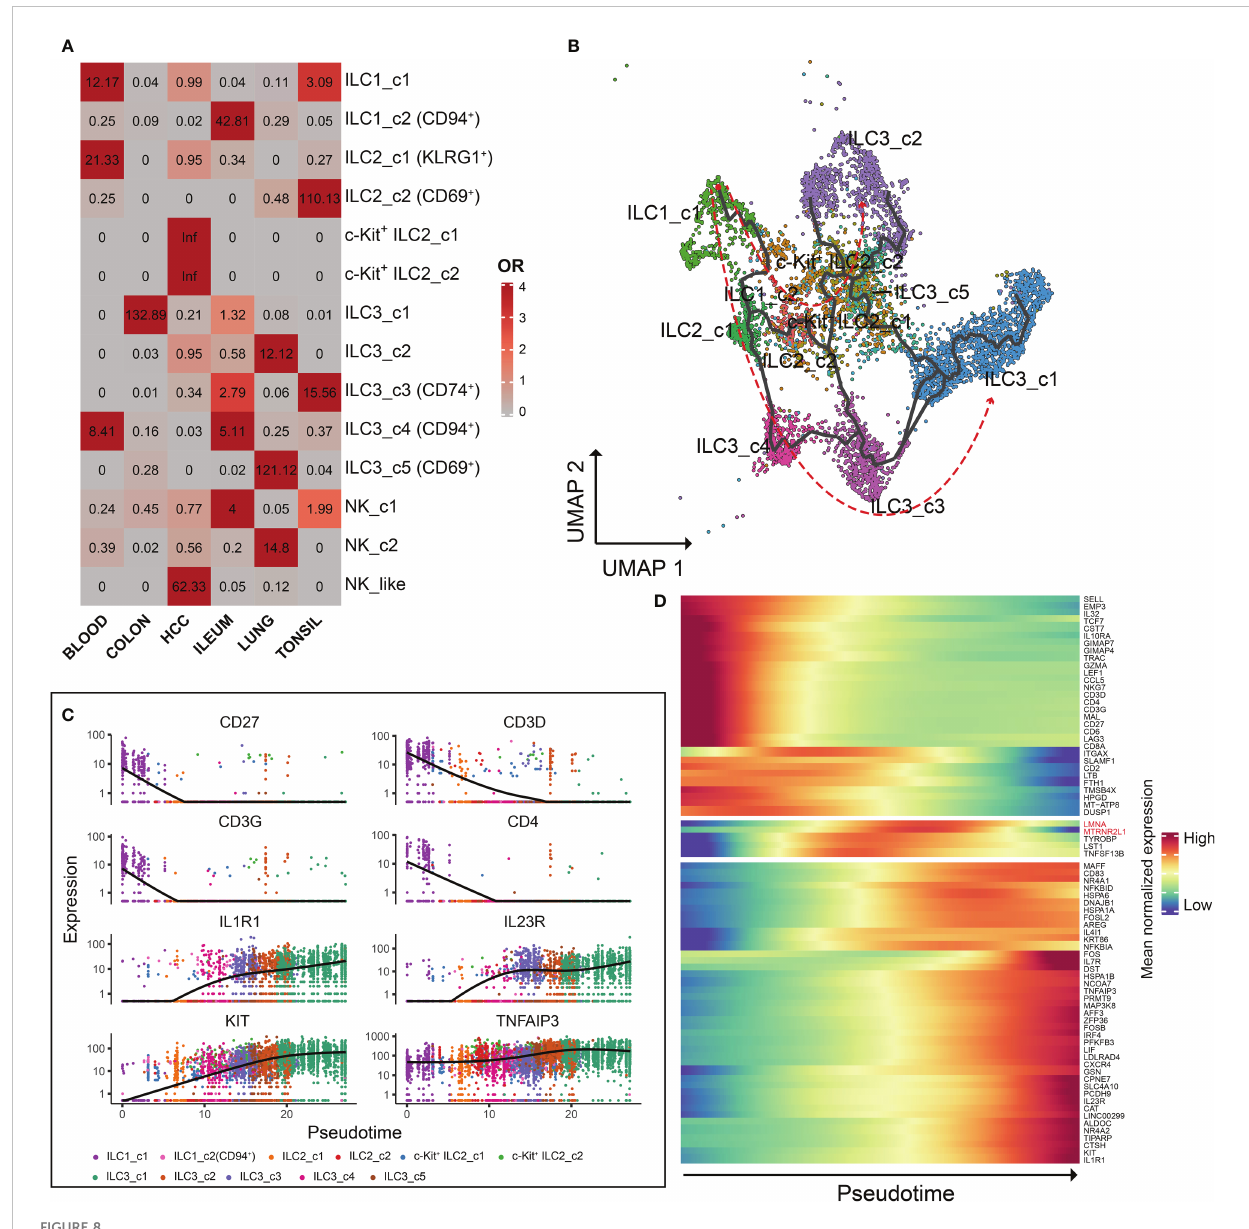
FIGURE 8 Characteristics and pseudotemporal gene expression analysis of the ILCs across different tissues. (A) Tissue prevalence of ILC clusters estimated by OR values. OR > 1.5 indicates that this ILC cluster is preferred to distribute in the corresponding tissue. (B) Pseudotime inference of the ILCs (excluding NK cells) trajectory with cells color-coded according to the corresponding ILC subsets identi fi ed by UMAP. (C) Monocle analysis reveals the kinetics of indicated genes ( CD27 , CD3D , CD3G , CD4 , IL1R1 , IL23R , KIT and TNFAIP3 ) across pseudotime. (D) Heatmap of gene expression analysis associated with ILC speci fi cation in